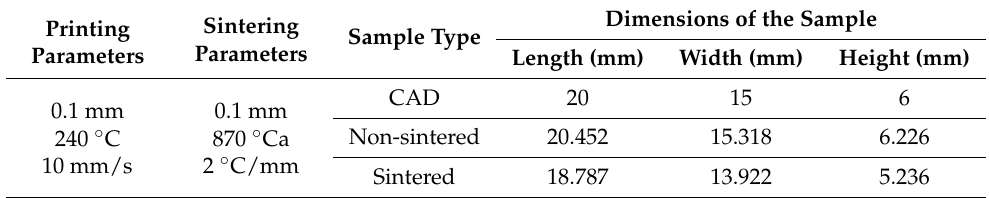
Table 3. Combination of the process